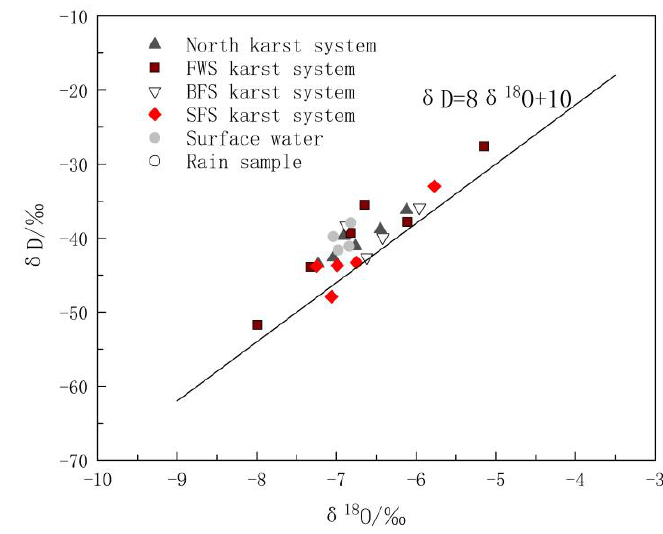
Figure 3. Hydrogen and oxygen isotopic compositions of water samples in the study area.